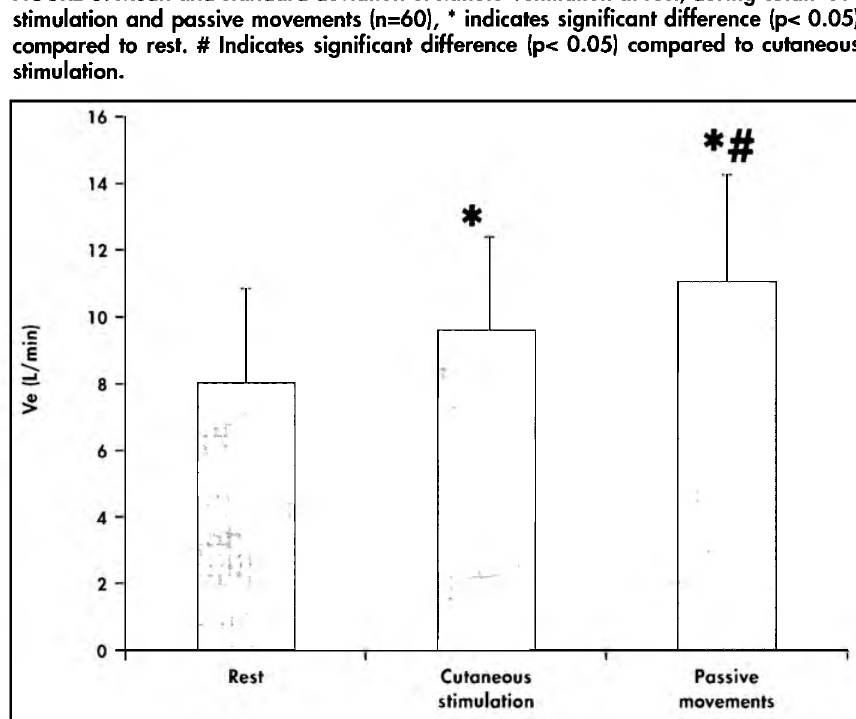
FIGURE 3. Mean and standard deviation of Minute Ventilation at rest, during cutaneous stimulation and passive movements (n=60), * indicates significant difference (p< 0.05) compared to rest. # Indicates significant difference (p< 0.05) compared to cutaneous stimulation.